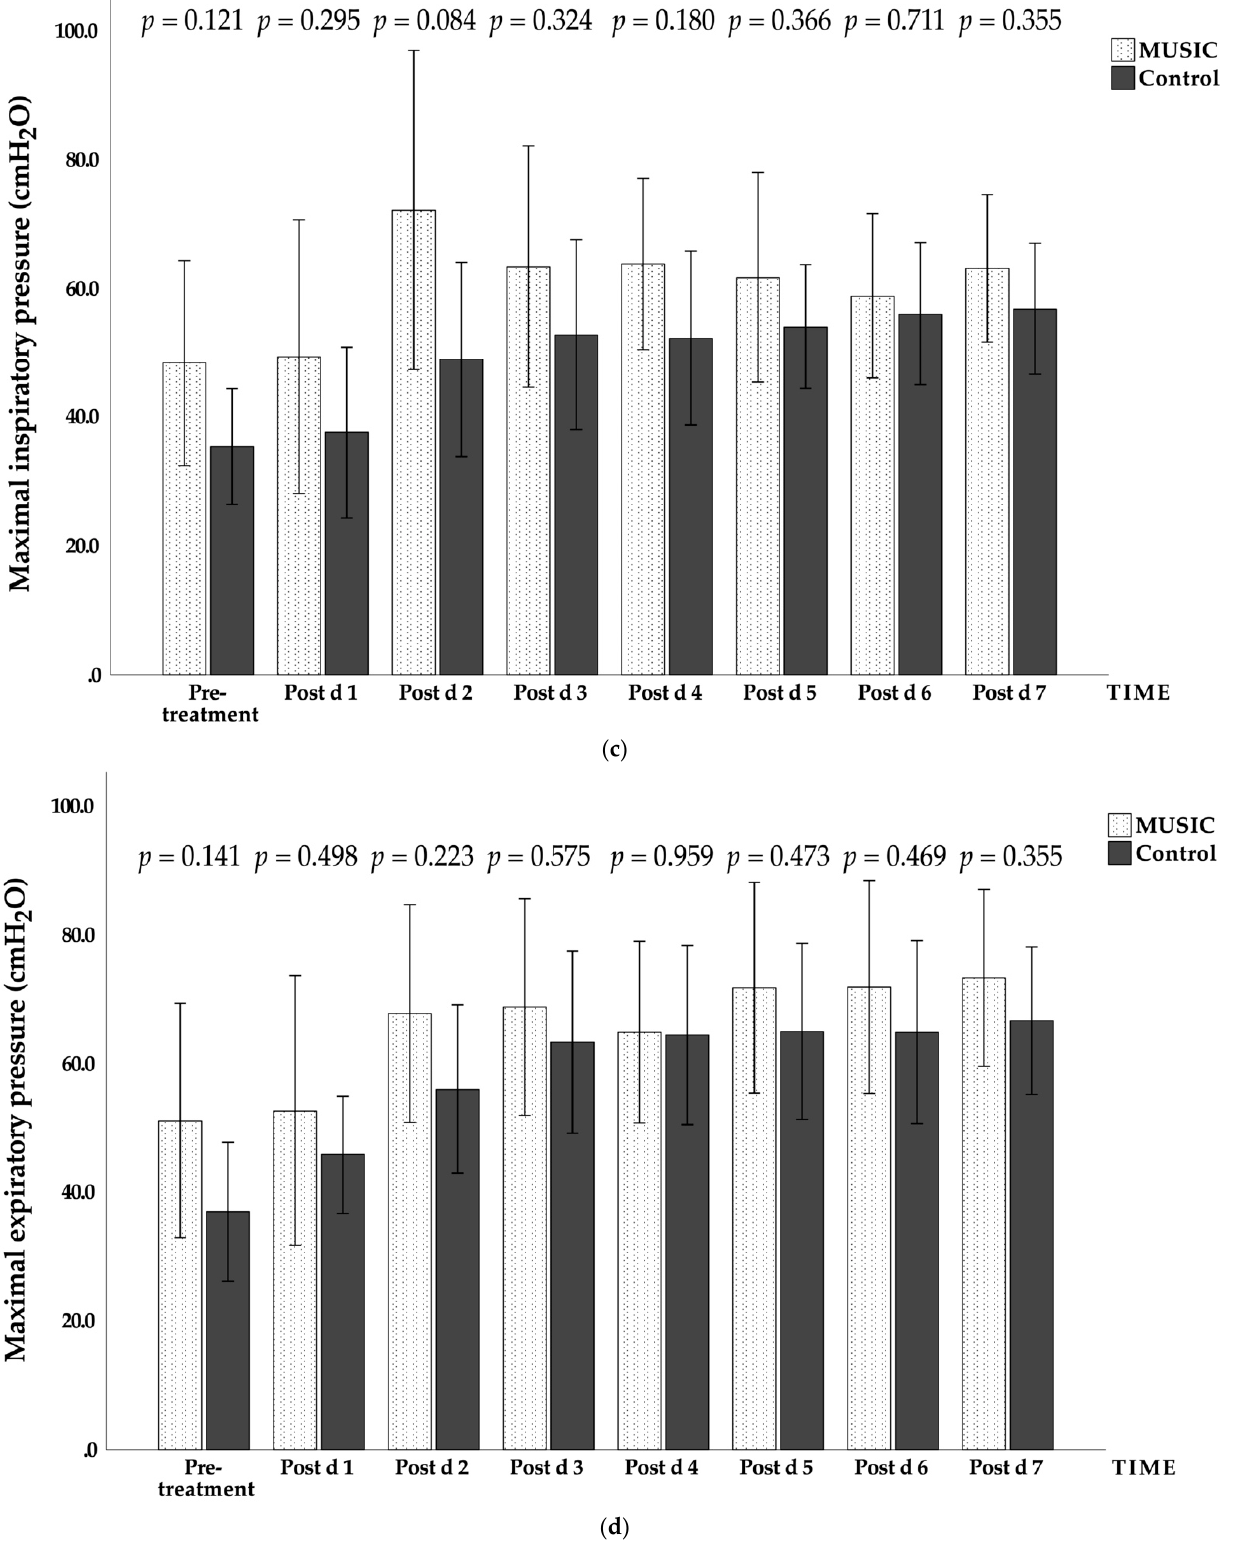
Figure 1. Daily changes in the music group and the control group during the trial. ( a ) Peak expiratory flow rate (PEFR), unit: L/min; ( b ) vital capacity (VC), unit: mL/kg; ( c ) maximal inspiratory pressure (MIP), unit: cmH 2 O; ( d ) maximal expiratory pressure (MEP), unit: cmH 2 O. Mean ± standard error (error bar: 95% CI). Post d, post-treatment